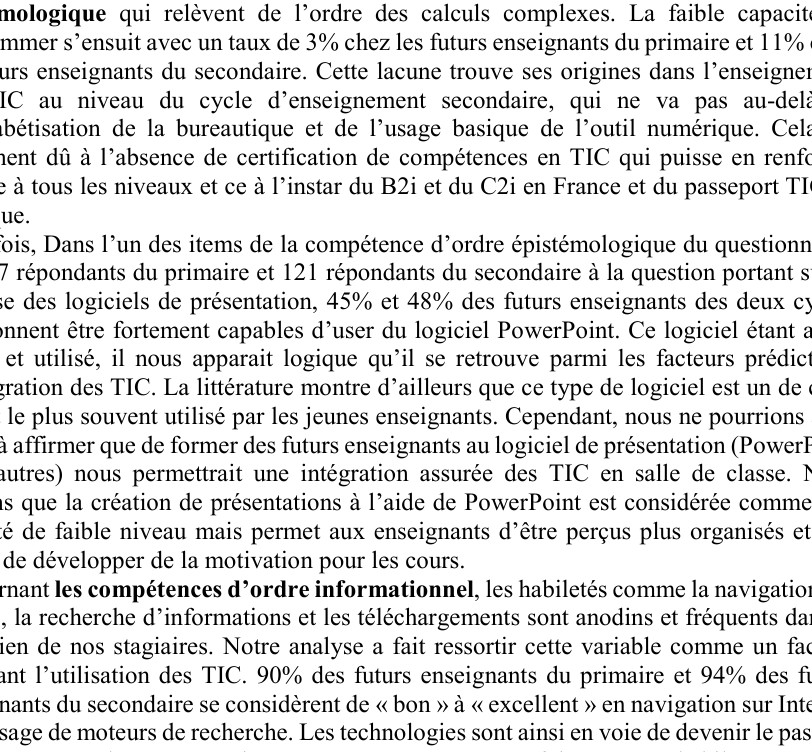
Fig.10. les compétences d’ordre technique déclarées maitrisées à l’issu de la formation au CRMEF.